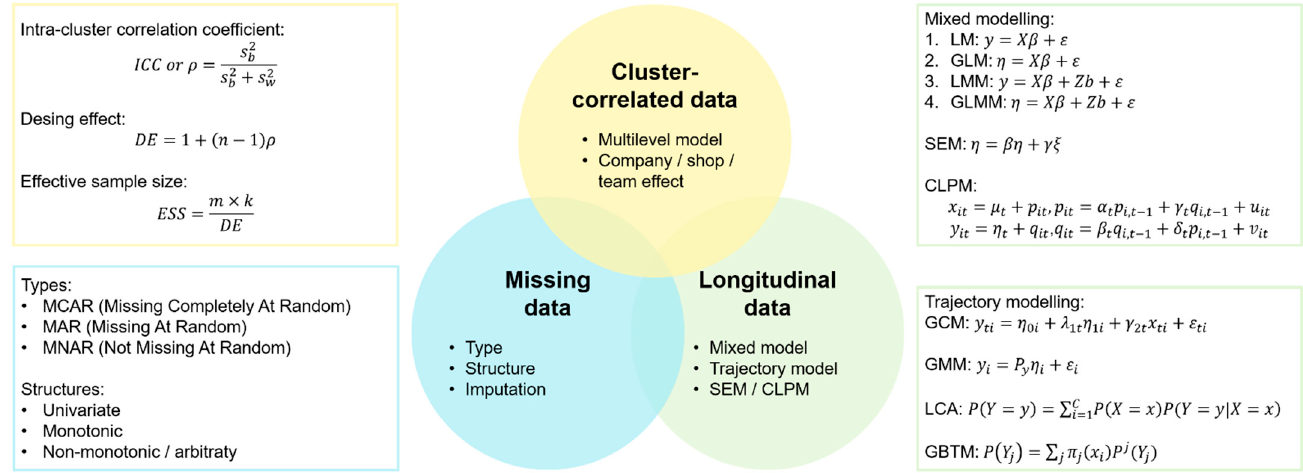
Figure A2. Main formulas for the methods presented to address methodological issues for analyzing real-world longitudinal occupational health data. Table A1 provides a summary of the main models and formulas presented here.